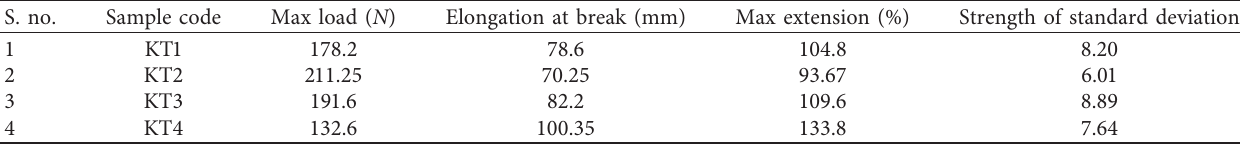
Table 3: Maximum breaking load and extension at break in the warp direction.